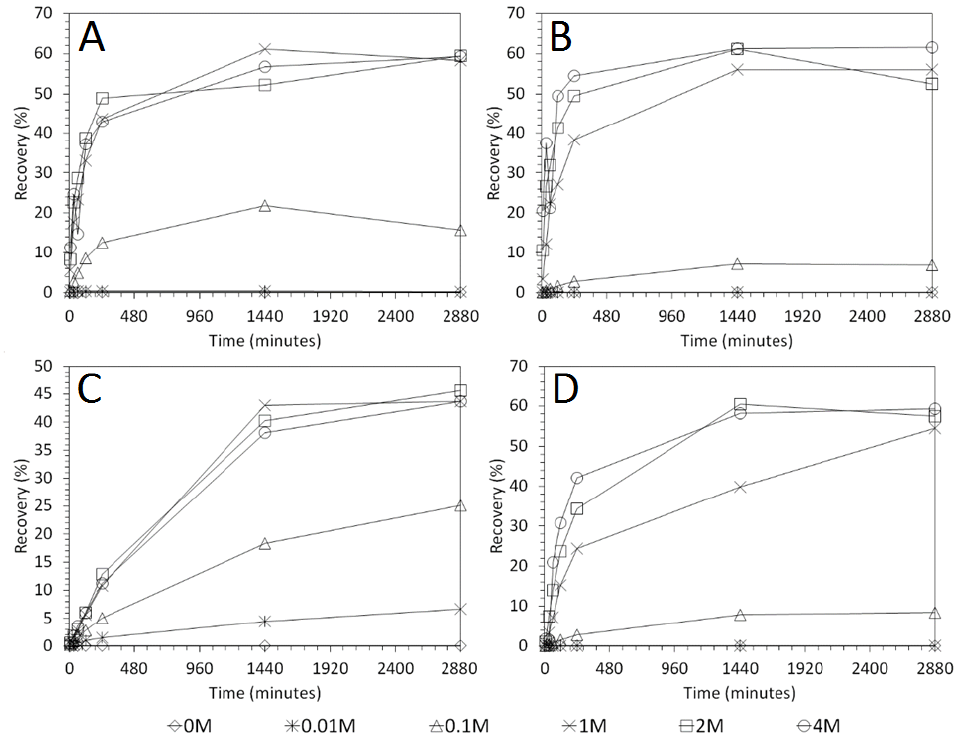
Figure 7. As recovery as a function of time for each acid concentration for each acid type: H 2 SO 4 ( A ), HCl ( B ), C 6 H 8 O 7 ( C ) and CH 3 SO 3 H ( D ). A solid – liquid ratio of 0.1 and lixiviant volume of 200 mL were used for each experiment.